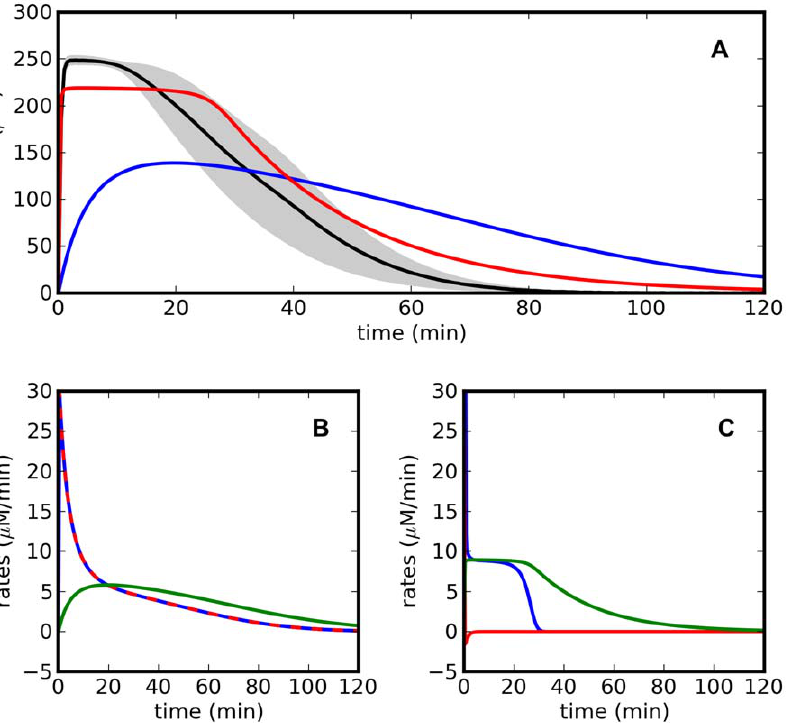
Figure 6. Discriminatory experiment for the kinetics of yeast glyoxalase I. A - Time courses of SDLGS concentration in the discriminatory setup experiment. Black: experimental result, average of 4 replicates (the grey shaded area is within one standard error of the mean). Blue: prediction by model 1. Red: prediction by model 2. Initial concentrations are 0.221 mM for glutathione, 2.0 6 10 2 3 mM for glyoxalase I, 0.441 mM for methylglyoxal and 4.0 6 10 2 3 mM for glyoxalase II. The initial concentrations correspond to the solution chosen from of the Pareto front highlighted in figure 4A. B and C - rates predicted by model 1 (B) and model 2 (C). Red: net rate of hemithioacetal formation, blue: rate of glyoxalase I reaction. green: rate of glyoxalase II reaction.